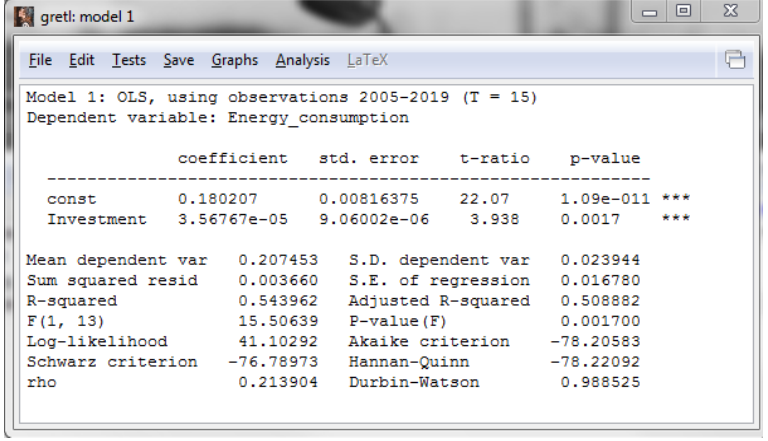
Figure 9. Econometric model.